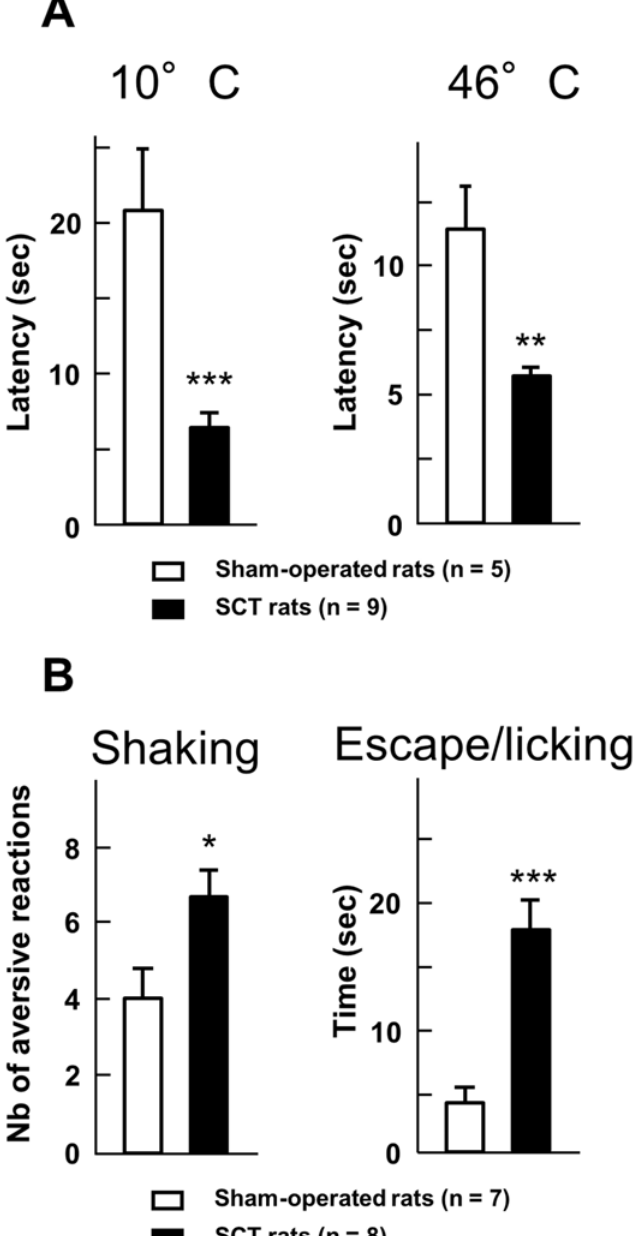
Fig 4. Hyper-responsiveness to thermal stimulation in spinal cord-transected rats. A – Latency (in sec) to hindpaw withdrawal was determined after paw immersion into a bath of hot (46°C) or cold (10°C) water, two weeks after the surgery. Each bar is the mean + S.E.M. of independent determinations in 9 SCT rats and 5 sham-operated rats. ** P < 0.01, *** P < 0.001 compared to respective values in sham-operated rats. Student ’ s t test. B – Behavioral responses to the acetone drop test applied at the surgical scar two weeks after surgery. The number of shakes and the time (in sec) spent in escape attempts and licking of the back were measured for one minute after acetone drops application. Each bar is the mean + S.E.M. of independent determinations in 8 SCT rats and 7 sham-operated rats. * P < 0.05, ** P < 0.01, *** P < 0.001 compared to respective values in sham-operated rats. Student ’ s t